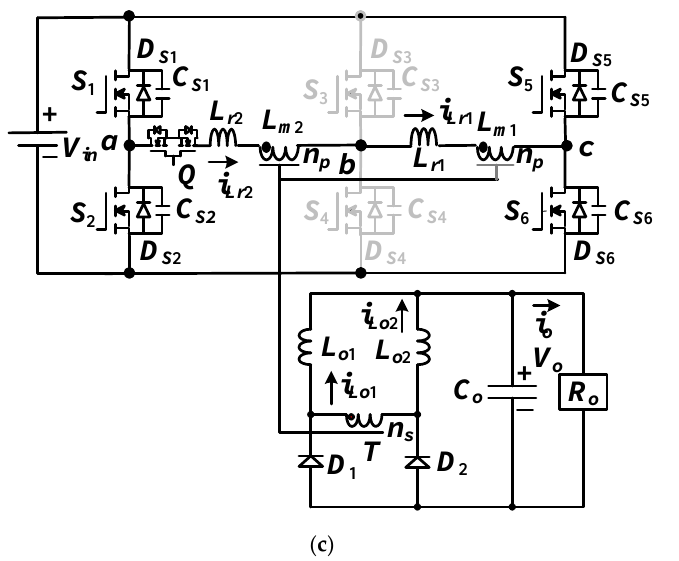
Figure 1. Proposed converter ( a ); circuit schematic ( b ); equivalent sub-circuit under low voltage input range ( c ); equivalent sub-circuit under high voltage input range.